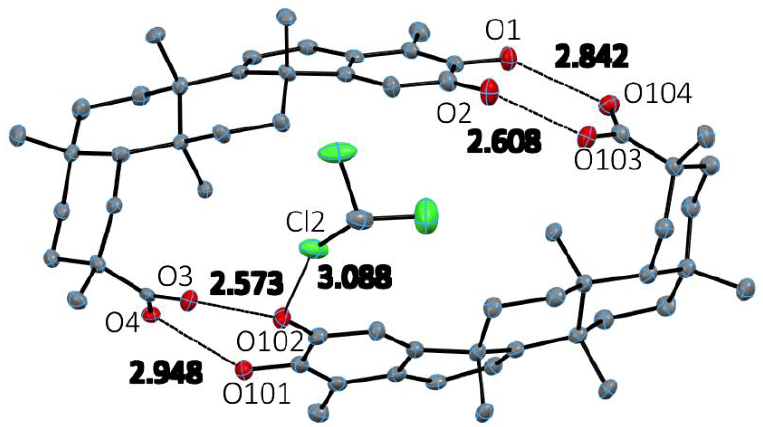
Figure 2. Celastrol molecule showing the conformation of the individual rings: planar for the methide quinone ring A on the left; envelope with C6 out of plane for adjacent ring B; remaining three rings are in chair conformation. H atoms are not shown for clarity.